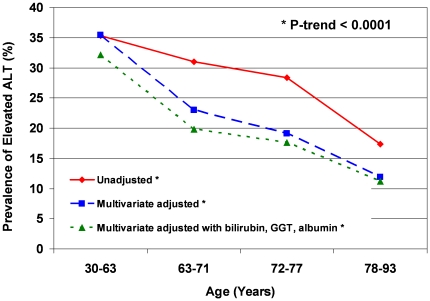
Prevalence of Elevated ALT by Age.The trend of decreasing prevalence of elevated ALT with rising age persists in unadjusted analysis, after adjustment for sex, BMI, systolic blood pressure, alcohol use, waist-hip ratio, diabetes, fasting glucose, total-HDL ratio, triglycerides, adiposity biomarkers (leptin, adiponectin, ghrelin, IL-6), and after adjustments for the above plus bilirubin, GGT, and albumin.